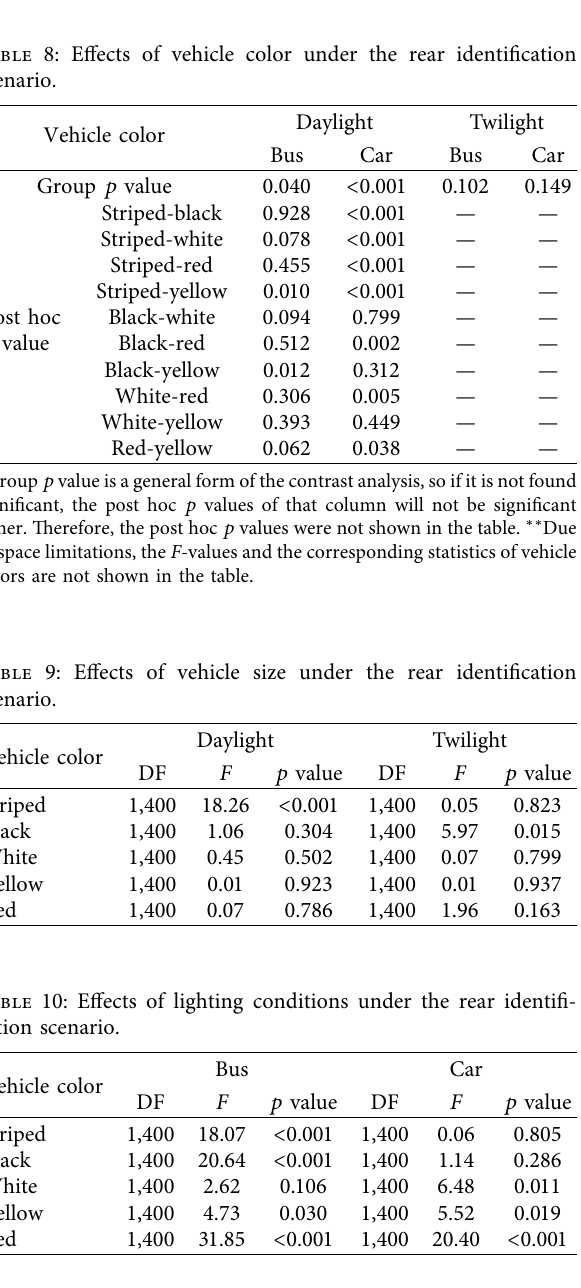
Table 8: Effects of vehicle color under the rear identification scenario.